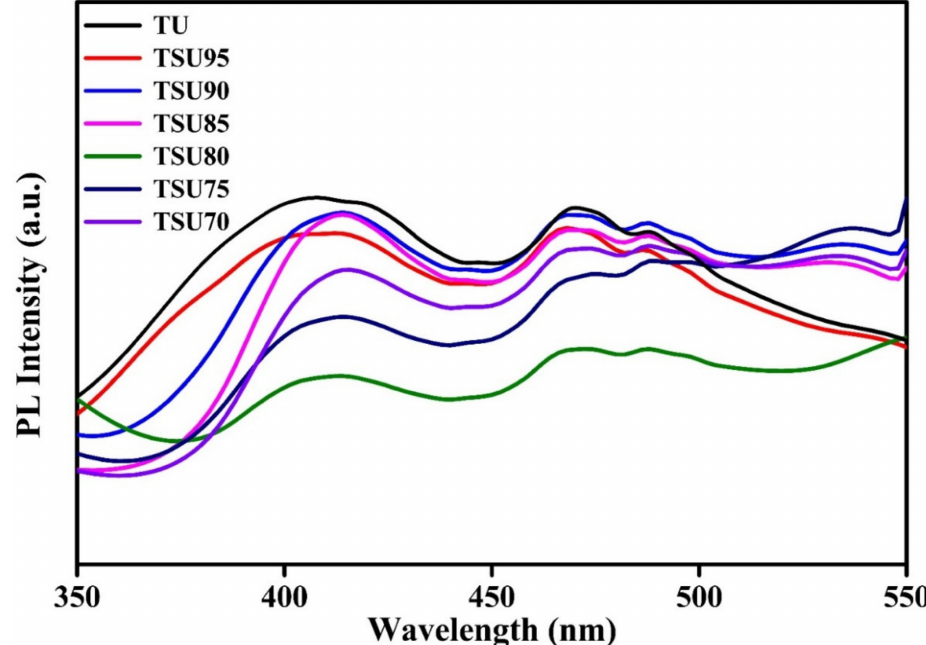
Figure 5. Photoluminescence (PL) spectra of TU, TSU95, TSU90, TSU85, TSU80 and